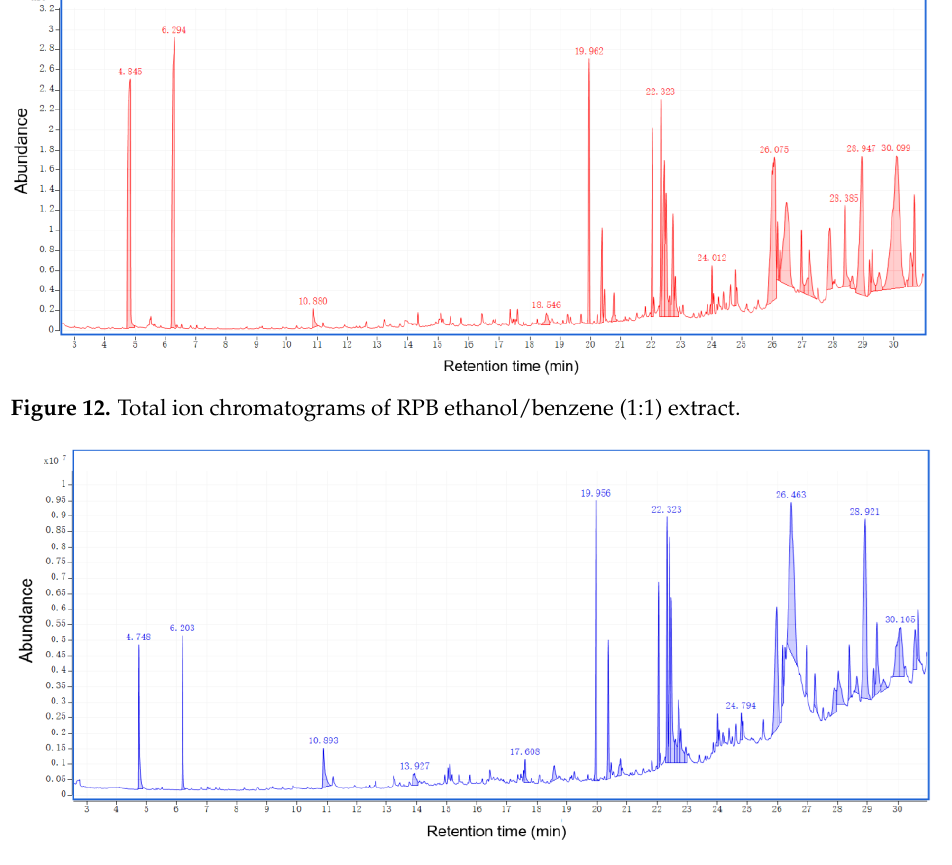
Figure 13. Total ion chromatograms of RPB ethanol/methanol extract.